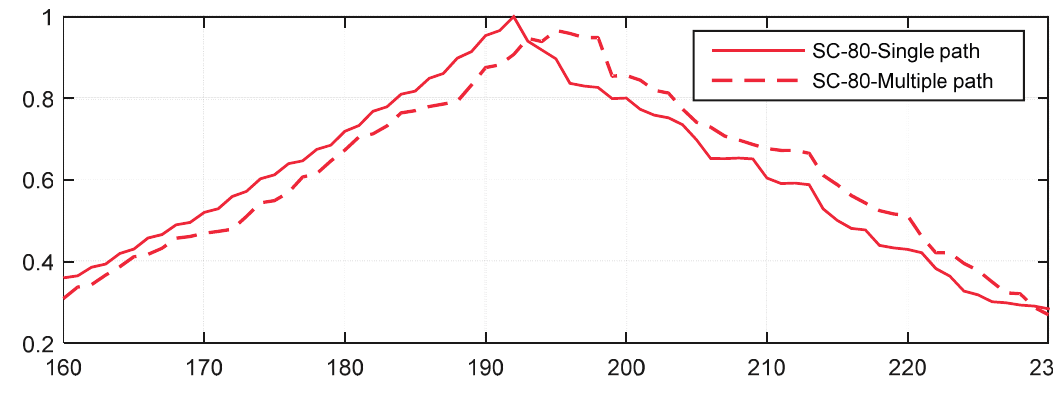
Figure 16. The effect of multipath channel on the timing metric of the SC-80